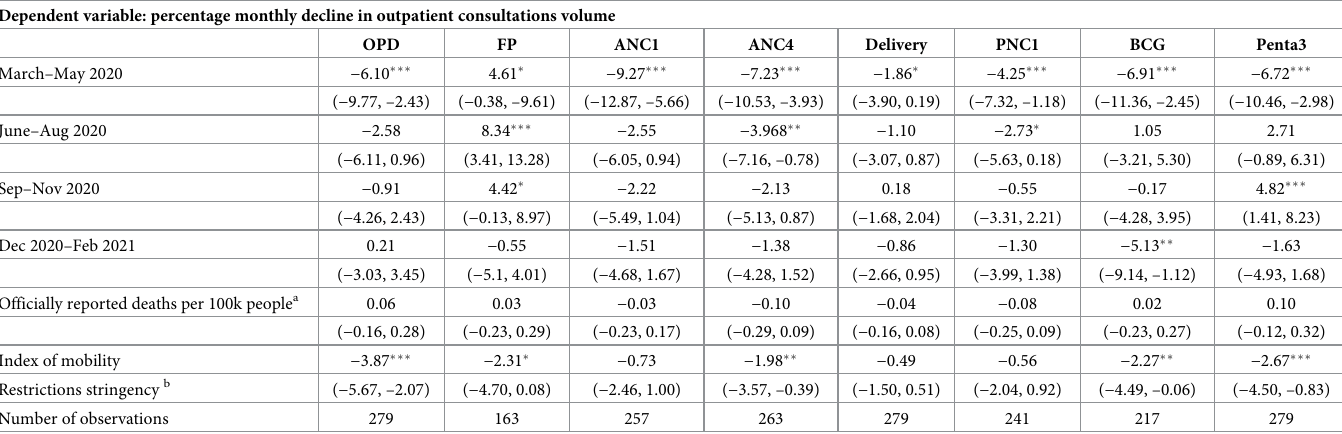
Table 3. Correlates of monthly disruption magnitude in service